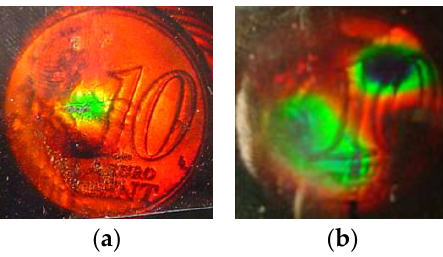
Figure 7. Denisyuk reflection holograms recorded of a 10-cent coin subjected to pressure. The pressure applied was: ( a ) 50 N/cm 2 for the green spot; ( b ) 70 N/cm 2 for the dark blue spot.